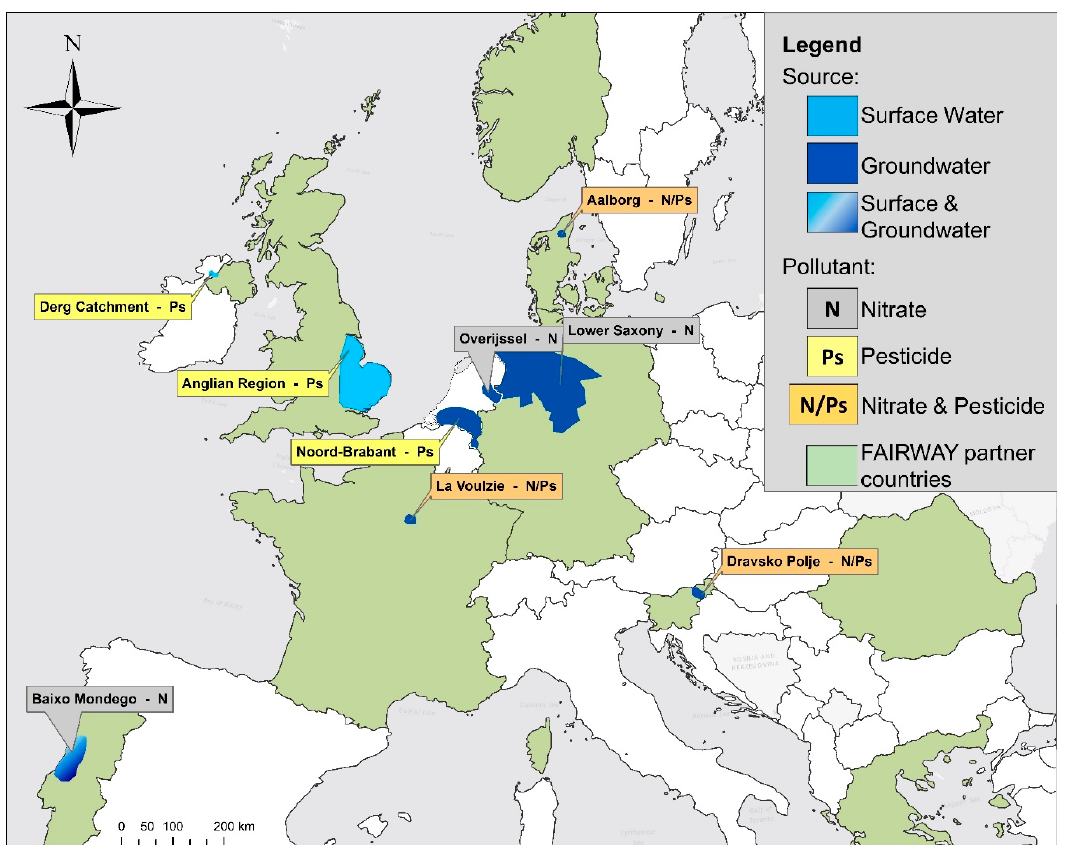
Figure 1. Location and overview of the 9 FAIRWAY case study sites involved in the DST evaluation, including the drinking water source, case study size and the main pollutant(s) of